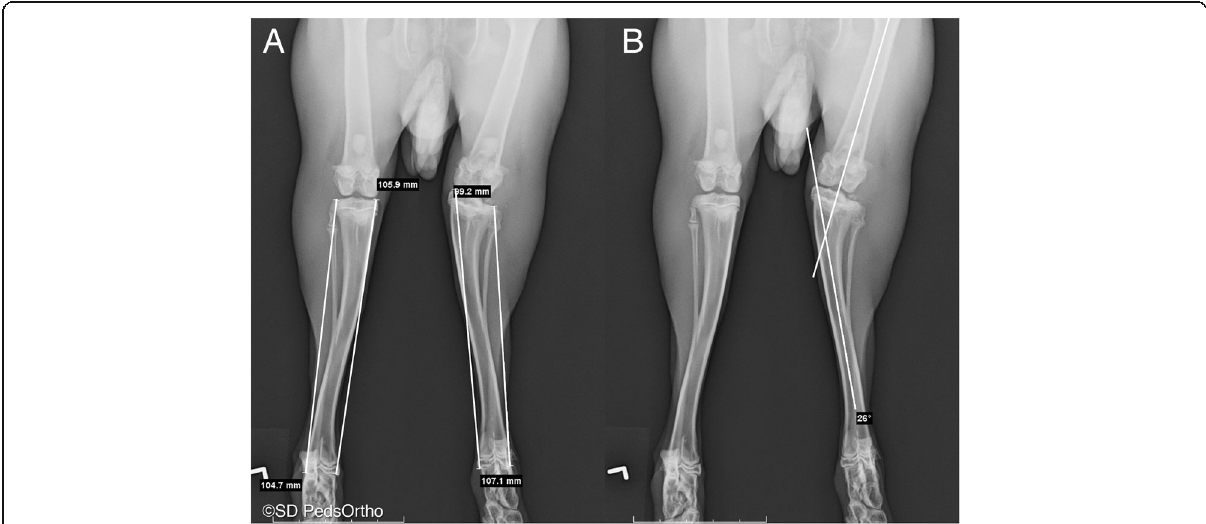
Fig. 2 Rabbit hindlimb radiographs. a DV radiographs with length measurements superimposed for the medial and lateral aspect of each tibia. b DV radiographs with the femoral-tibial axis angle (FTA) shown